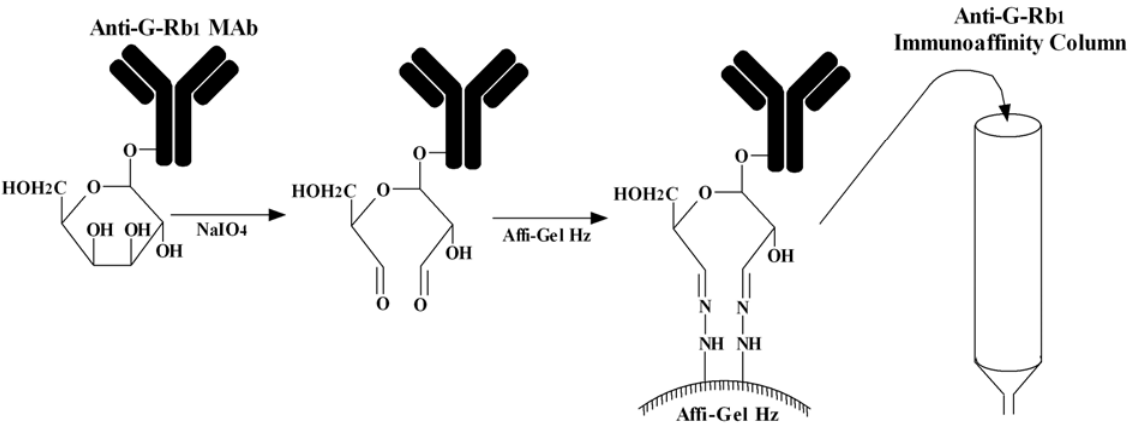
mAb-coupled immunoaffinity 1